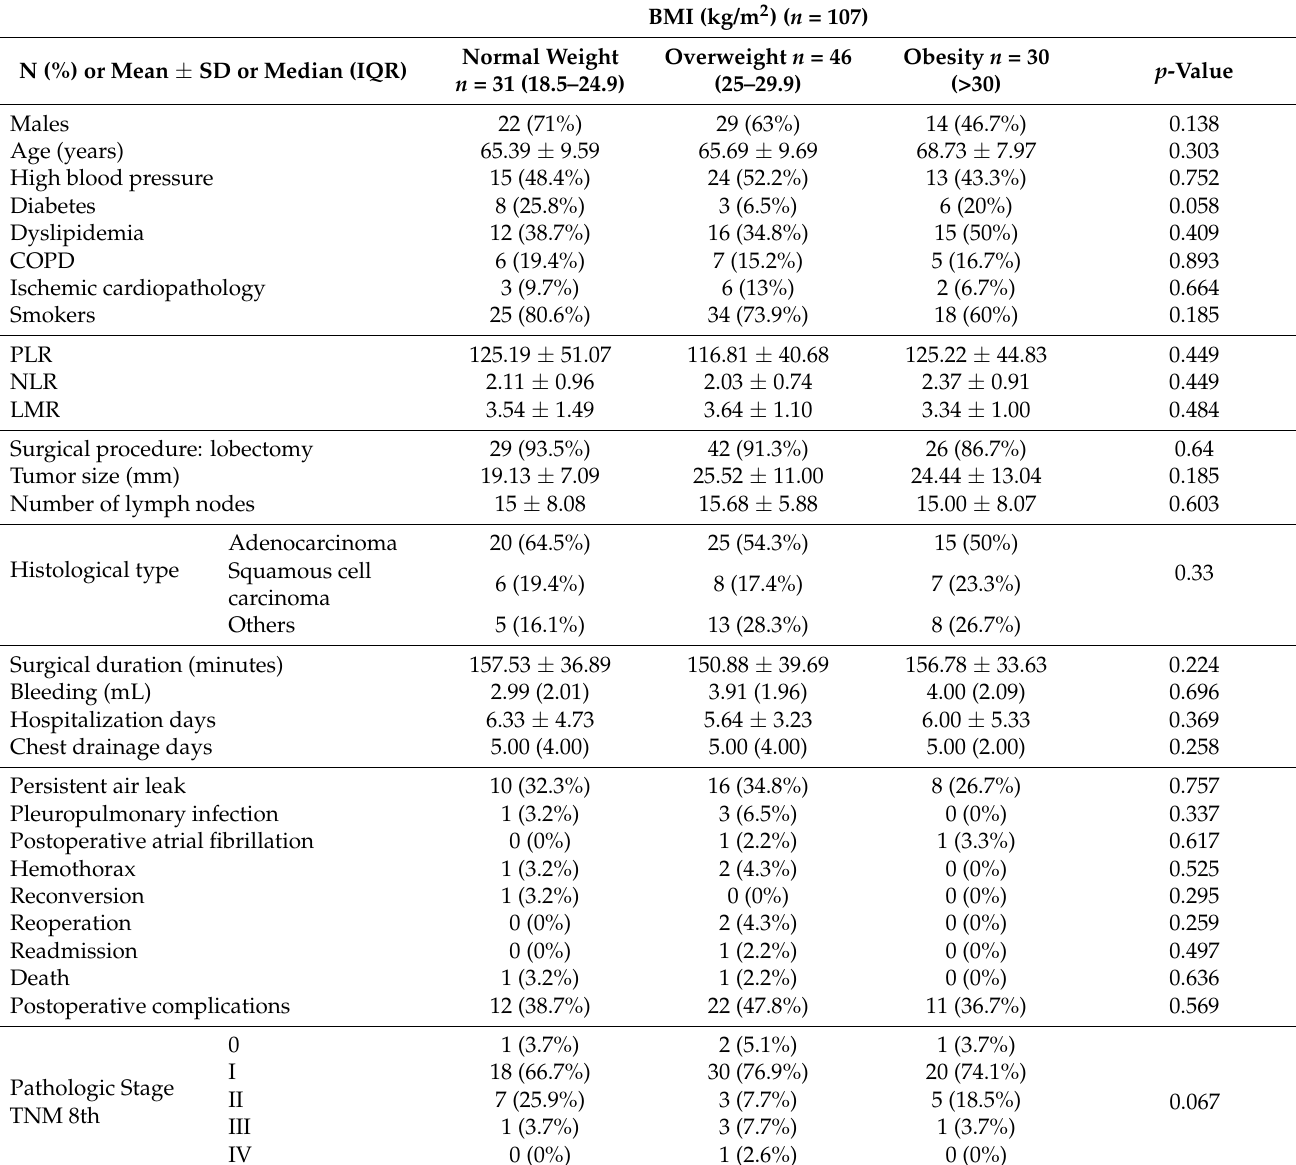
Table 2. Clinical, pathological, and surgical parameters, and postoperative complications, according to